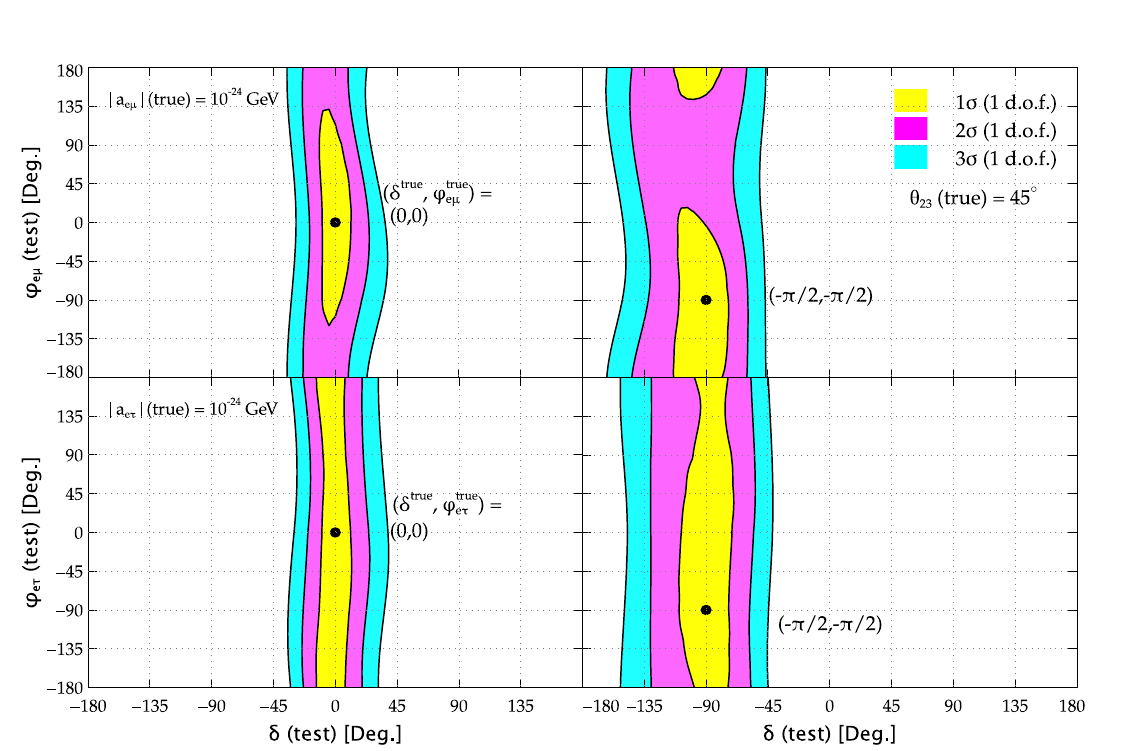
Fig. 9 Reconstructed regions for the two CP phases δ and ϕ e μ (top panels) at 1 σ , 2 σ , and 3 σ (1 d.o.f.) confidence levels assuming NO both in data and theory. The bottom panels show the same for the two CP phases δ and ϕ e τ . The two left (right) panels refer to the representa- tive true values of the phases [0, 0] ([ − π/ 2 , − π/ 2]). In all the panels,